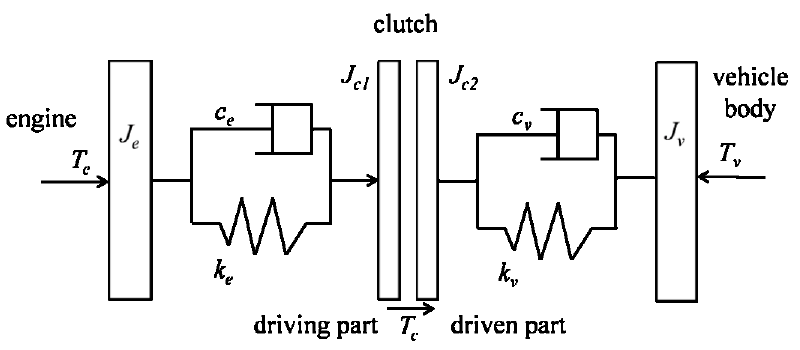
Figure 3. Powertrain model.